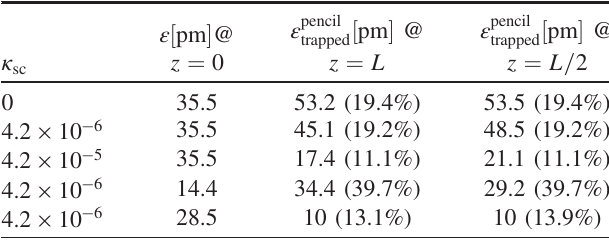
ε pencil ε pencil ε ½ pm (cid:2) @ ½ pm (cid:2) @ ½ pm (cid:2) trapped trapped z ¼ 0 z ¼ L